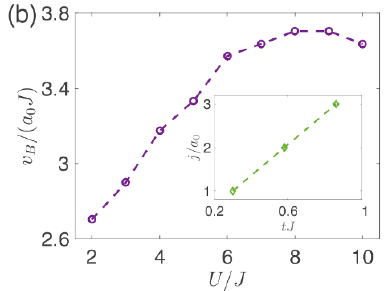
Figure 4 . Butter(cid:13)y velocity v B as a function of coupling U=J at temperature (cid:12)J = 0 : 9. This plot is taken from [32].